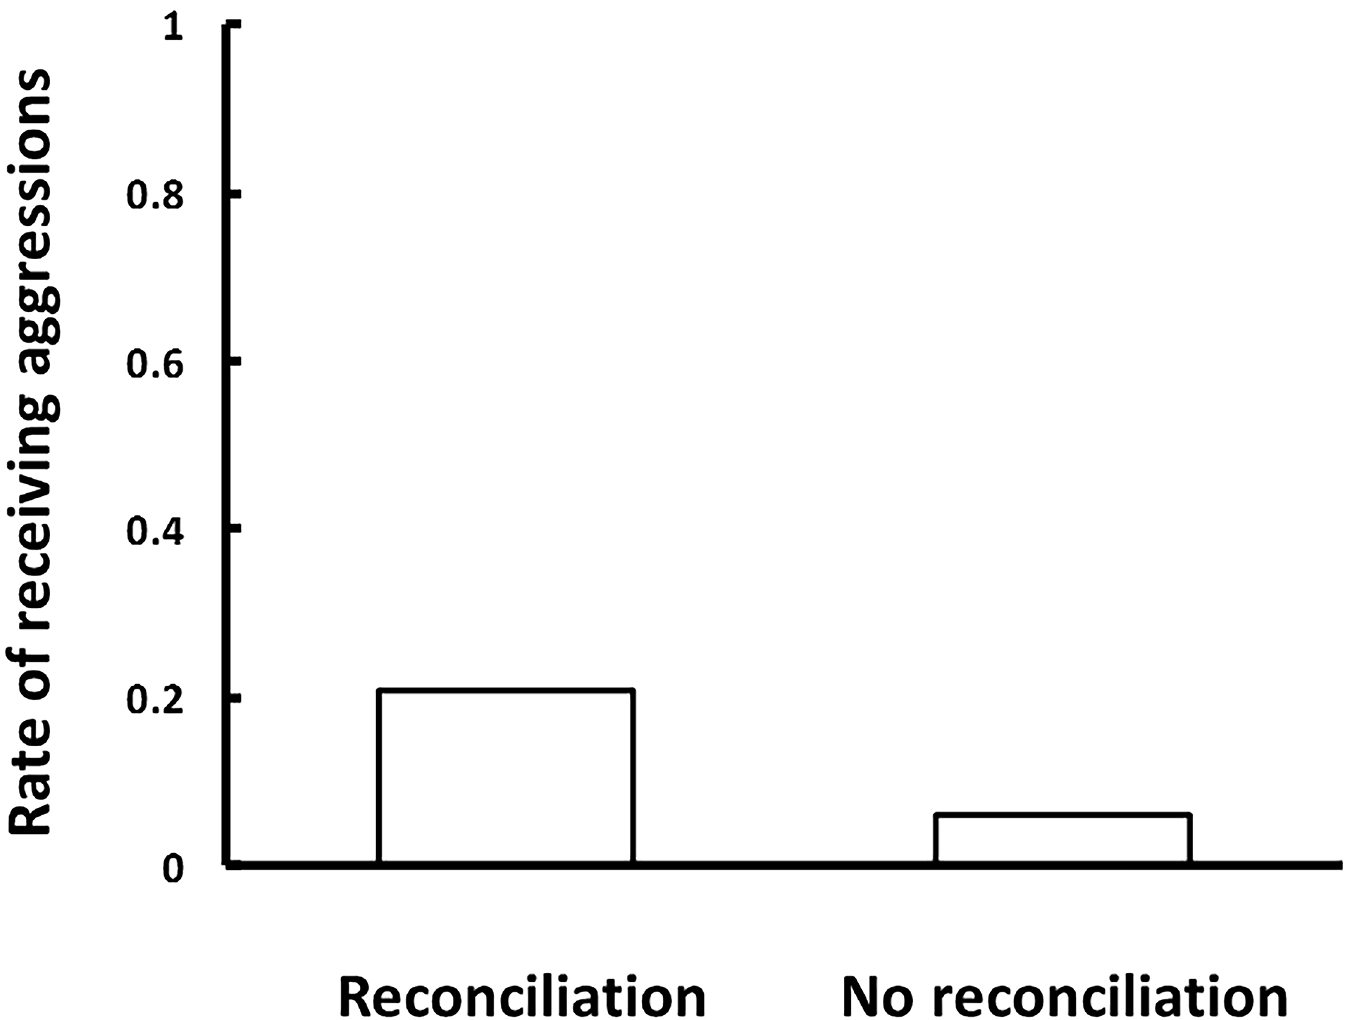
Fig 1. Differences between the proportions of post-conflict (PC) sessions during which victims receivedaggression after experiencing affiliative behaviors with the former opponent (reconciliations: n = 72) or not ( n = 233).